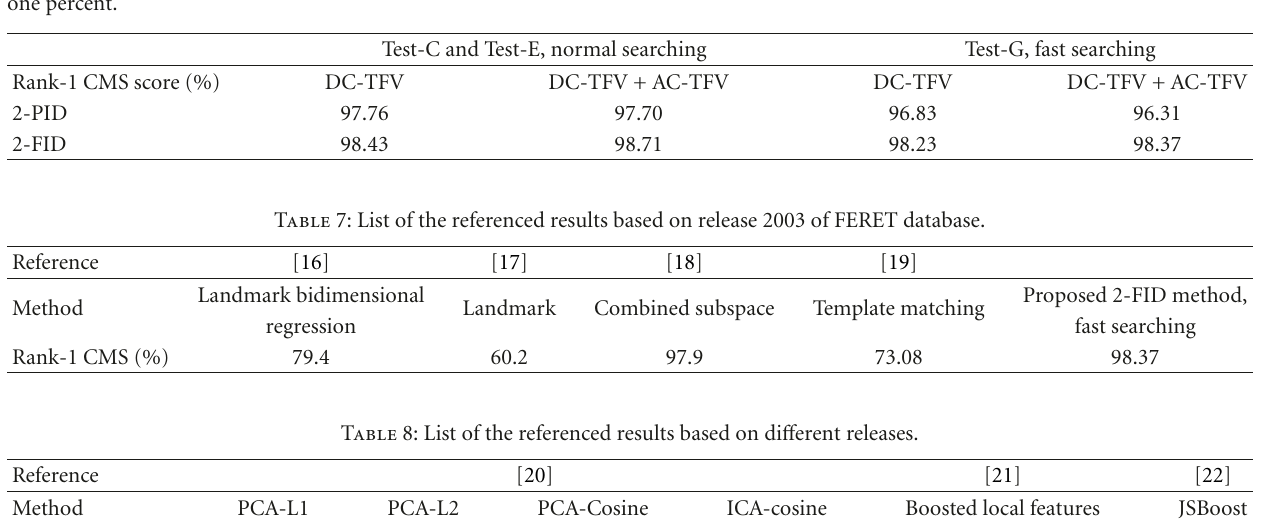
Table 6: Comparison between the results of Test-C and Test-G for two subareas. The di ff erence between the resulting CMS scores is less than one percent.